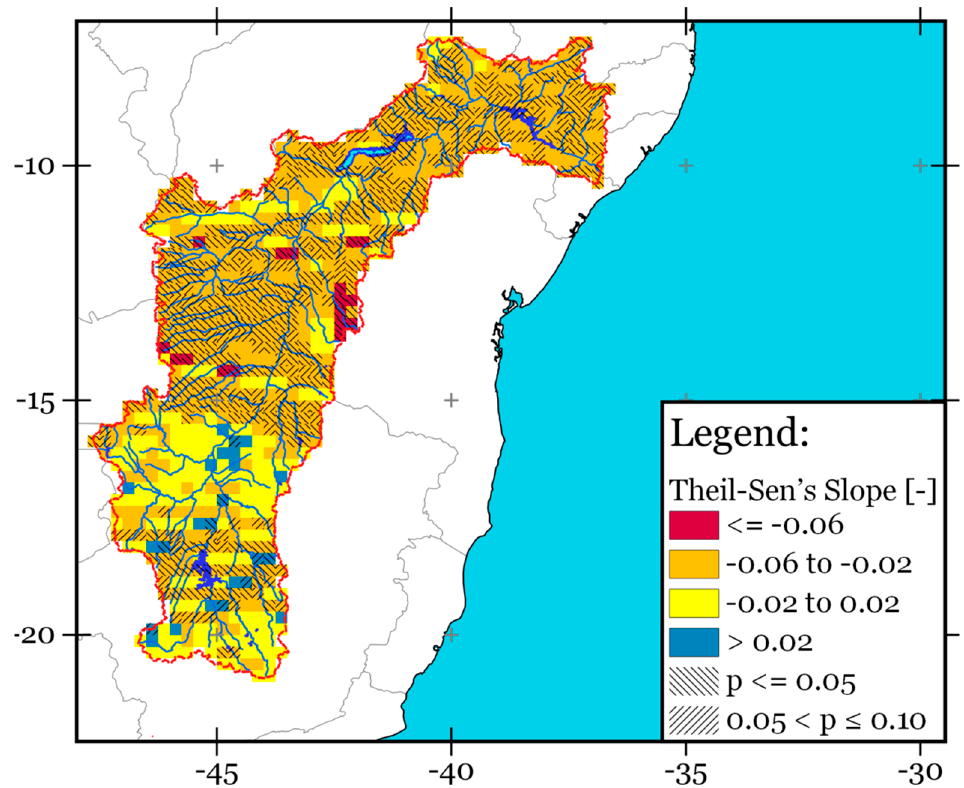
Figure 3. Spatial–temporal trend of SPEI12 at December over the SFRB during 1980–2015. The blue and orange–red tones represent areas with wetting and drying trends, respectively. The black hatched lines show those regions with statistically significant Theil–Sen’s slope. The reference period of 1980–2015 was chosen for the calculation of the SPEI.